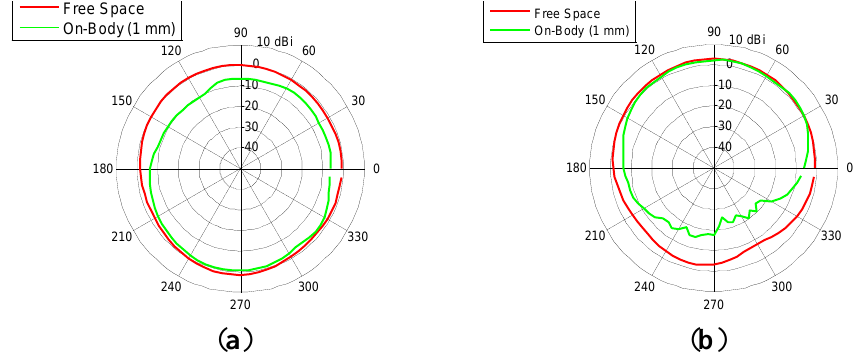
Figure 6. Free space and on-body radiation patterns of the dual band PIFA at 2.45 GHz; ( a ) XZ plane at 2.45 GHz and ( b ) YZ plane at 2.45 GHz.